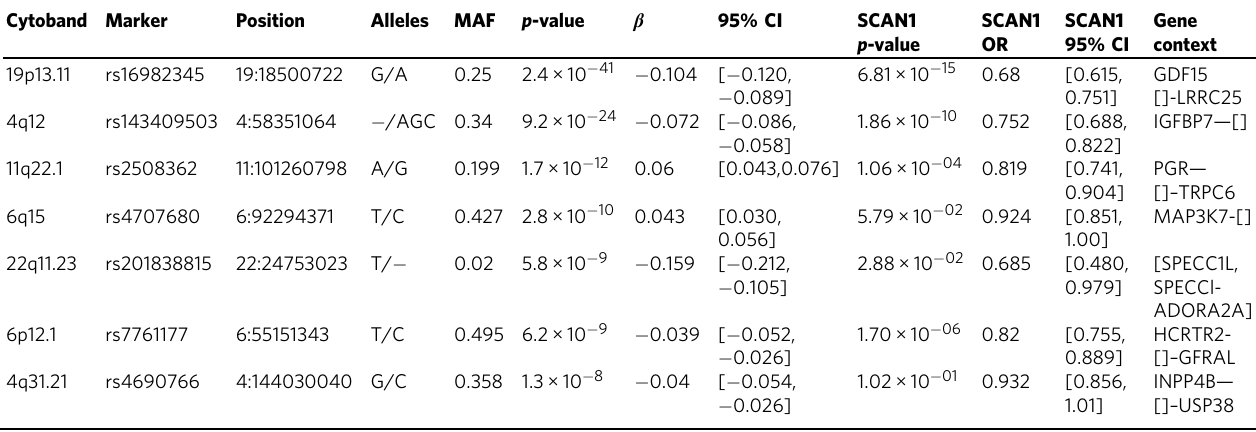
Table 4 Results of GWAS of NVP as an ordinal response (SCAN2) with p < 5 × 10 − 8 . The directions of effect correspond to the minor allele, listed second Cytoband Marker